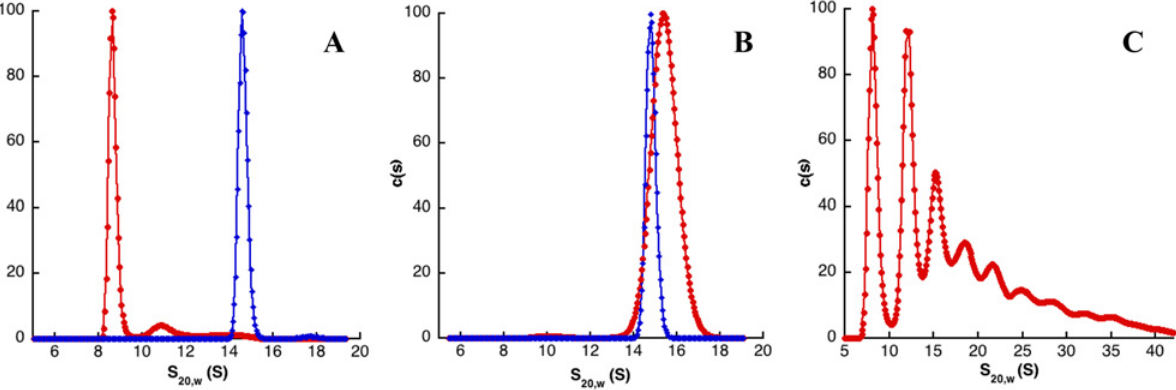
Fig 2. Continuous sedimentation coefficient distribution analysis of IMPDHbt (A), IMPDHlpp (B) and IMPDHkp (C) at 1 mg/mL (corresponding to 18.5, 18.3 and 18.4 μ M, respectively) in the absence (red curves) or presence of 3 mM MgATP (blue curves). Sedimentation coefficients (S 20, w ) are expressed in Svedberg units (1S = 10 -13 s) and c(S) corresponds to normalized continuous size